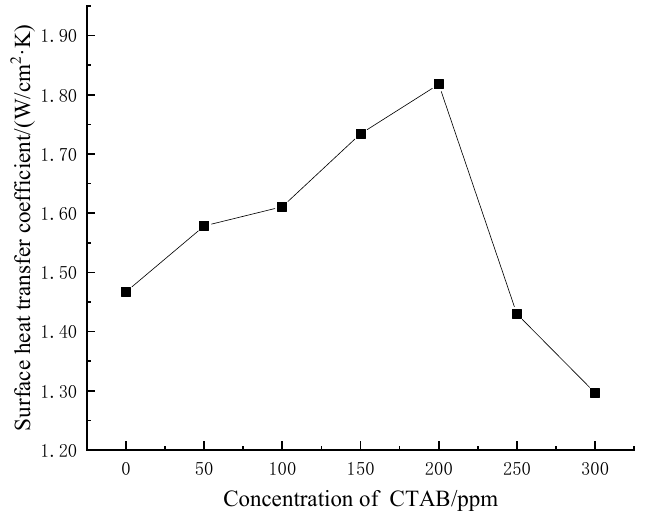
Figure 23. The steady-state heat transfer coefficients of the ethanol–water mixture at different CTAB concentrations.